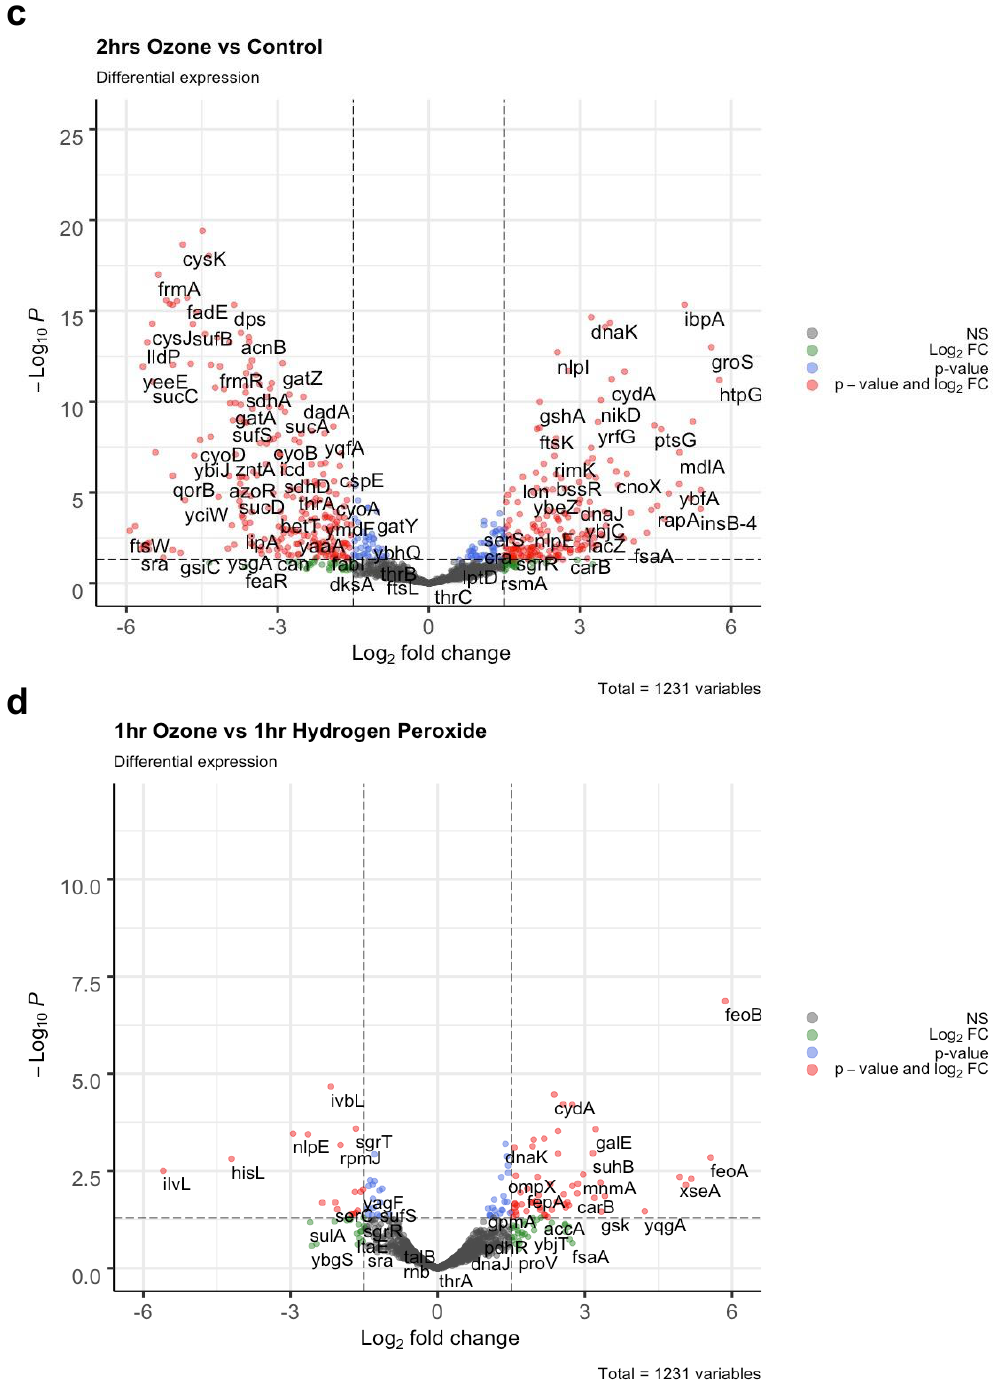
Figure 3. Top differentially expressed E. coli K12 Genes. ( a ) E. coli K12 cell viability was assessed by measuring presence of ATP immediately after ozone treatment. ATP signal was measured via luminescence and expressed as Relative Light Units (RLU). Bacteria species at each time point were compared to corresponding control 0 min (Significance codes 0.01 **, Student’s paired t -test). ( b ) E. coli K12 at 0 h no treatment were compared to E-coli K12 subjected to 20 ppm of ozone at 30 min, 1 h, and 2 h, along with 100 uM H202 treatment for 1 h. Differential expression fold changes are evaluated based on |Log2FC| > 1.5. 263 genes were downregulated while 184 were upregulated, LogCPM values were selected for the top 30 differentially expressed genes. ( c ) Differential expression was analyzed between 2 h of ozone treatment compared to no treatment control and ( d ) 1 h of ozone treatment compared with 1 h of hydrogen peroxide treatment, LogFC > Log 2 (1.5) and p cutoff =